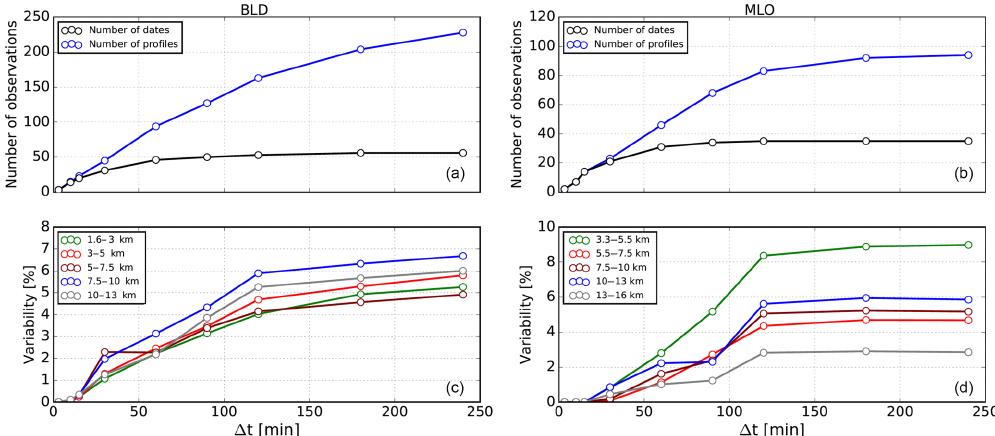
Figure 6. Panels (a, b) show the number of dates (black) and profiles (blue) measured by the FTIR at BLD (a, c) and MLO (b, d) as a function of the length of the time interval in minutes. The bottom panels show the temporal variability in percent estimated with the ratio of the standard deviation to the mean values for several layers as a function of the length of the time interval. The length of the time intervals are defined as an increasing temporal window, e.g., 0–30, 0–60, 0–120min, and the number of retrievals in each window is used to calculate the